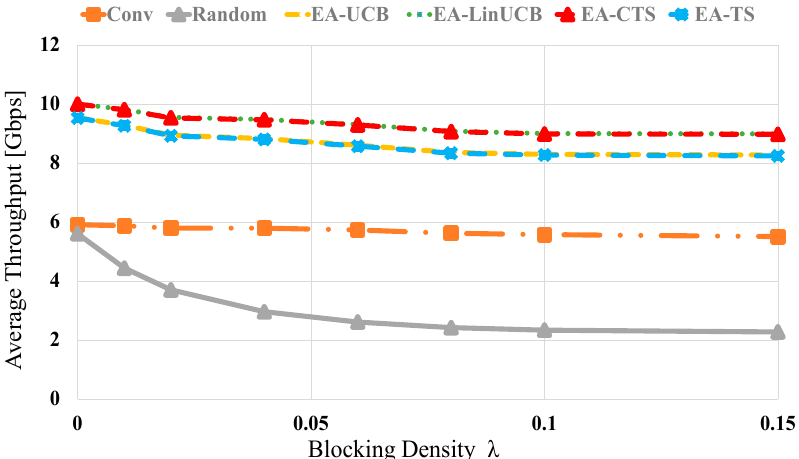
Figure 7. Average throughput versus blocking density λ for EA-UCB, EA-TS, EA-LinUCB, and EA-CTS using 60 devices.